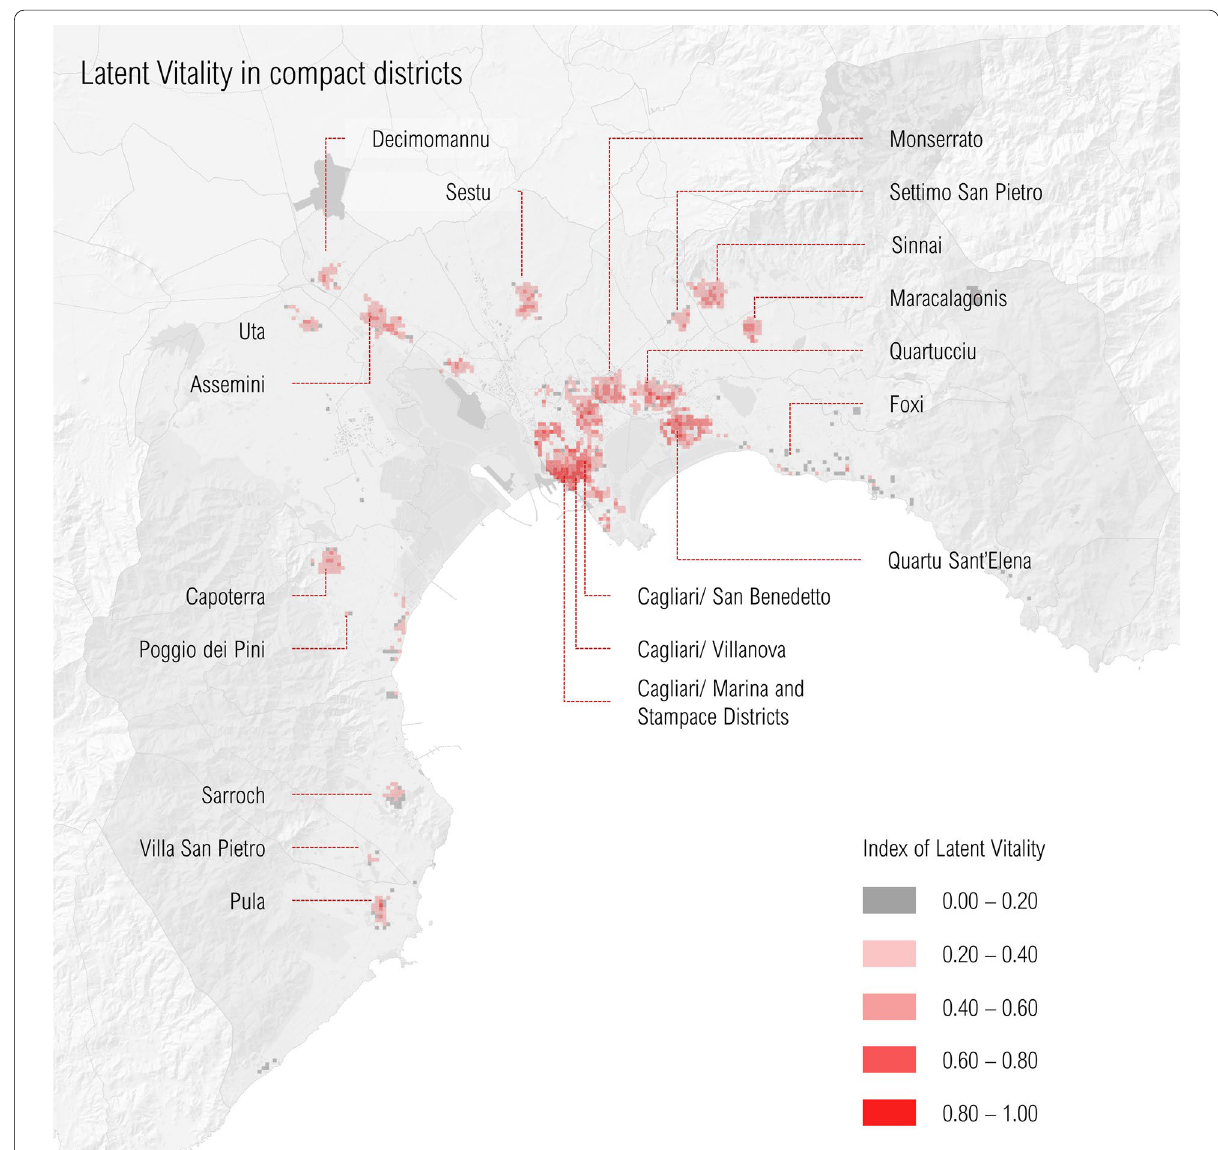
Fig. 5 Distribution of the values of the Synthetic Index of Latent Vitality (I_VIBE) across the centres of ancient formation and the compact areas of development in the Metropolitan City of